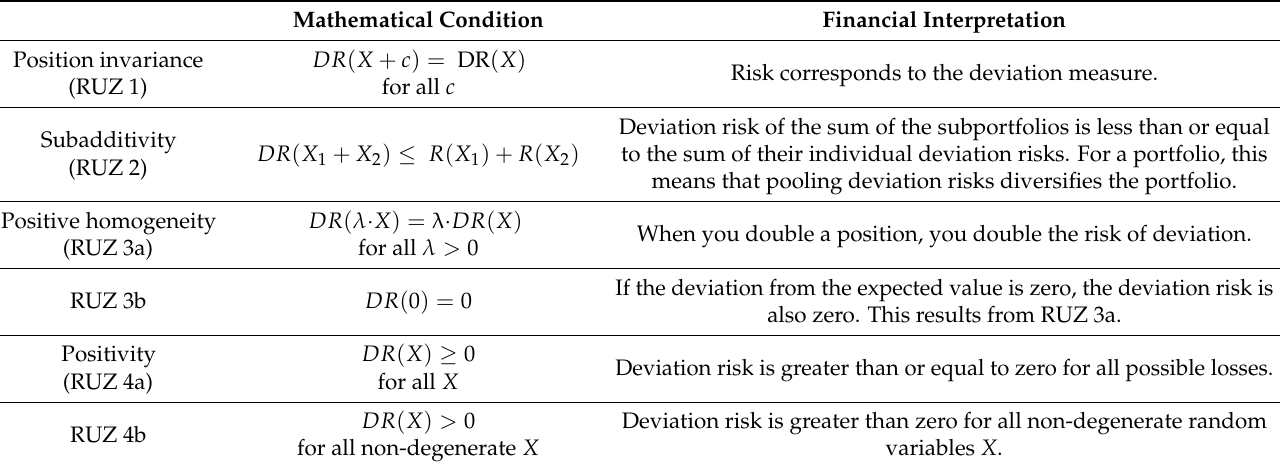
Table 4. Rockafellar, Uryasev, and Zabarankin axiom